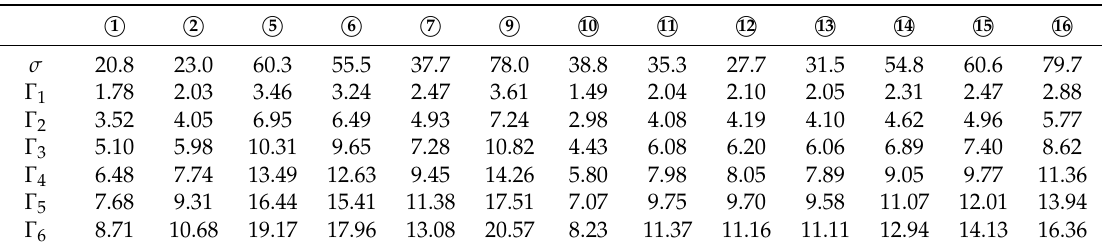
Figure 4. Schematic view of zones in the China Western Pacific area. Table 1. Characteristic parameters of gravity anomaly in various regions of the China Western Pacific area.